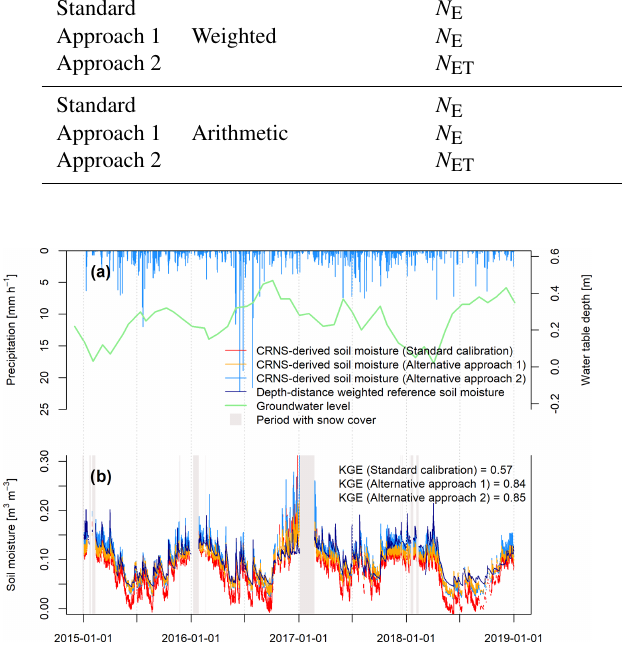
Figure 11. On-site observed hourly rainfall sums (a) and CRNS- derived soil moisture time series, based on the standard calibration approach and alternative approaches 1 and 2, in comparison to the depth–distance weighted reference soil moisture time series derived from SMT-100 sensors (b) for a 3-month period in the summer of